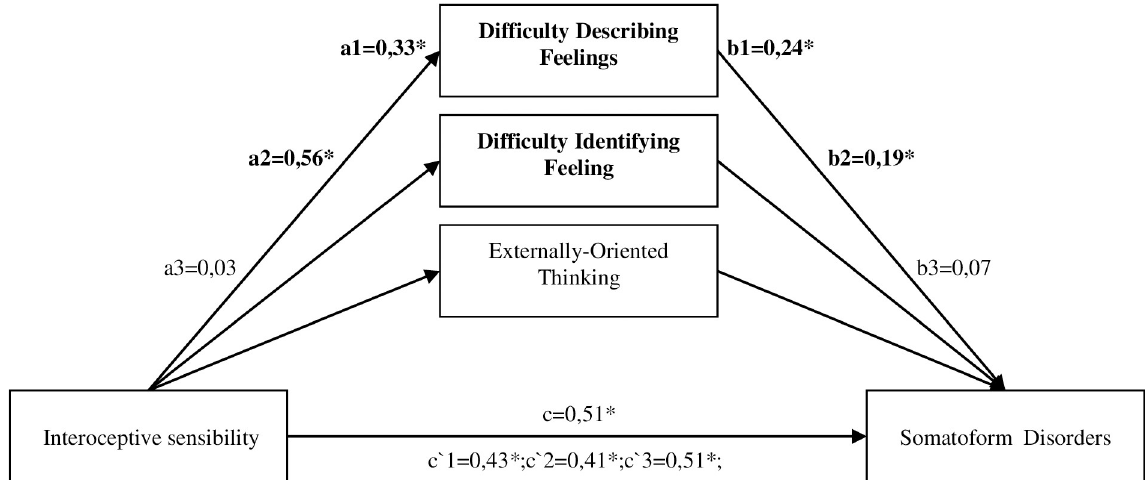
Fig 4. The model of mediation for the tendency toward alexithymia between the impact of interoceptive sensibility (autonomic reactivity) on the level of somatoform disorders. � -p < 0,05; Significant mediation relation are marked in bold. Direct effect–X on Y without the influence of M1 –c. Indirect effect of X on Y through M—a1,b1; a2,b2; a3,b3. Direct effect–X on Y including the influence of M–c‘1;c‘2;c‘3. Interoceptive sensibility (autonomic reactivity) was measured by Body Perception Questionnaire-Short Form (BPQ-SF). Somatoform disorders was measured by Somatoform Dissociation Questionnaire (SDQ-20). Alexithymia was measured by The Toronto Alexithymia Scale– 20 (TAS-20).